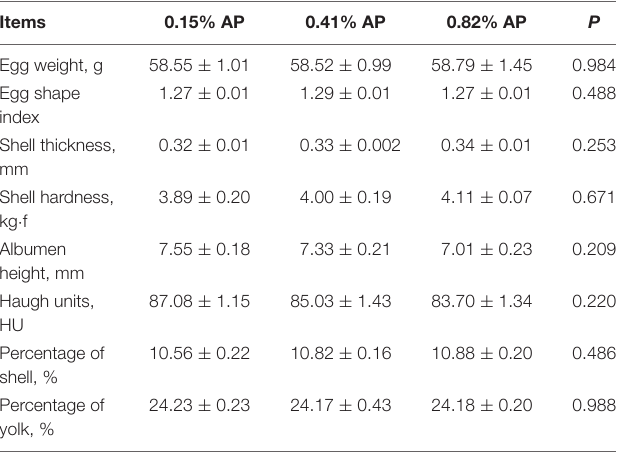
TABLE 2 | Effects of dietary available phosphorus level on egg quality of laying